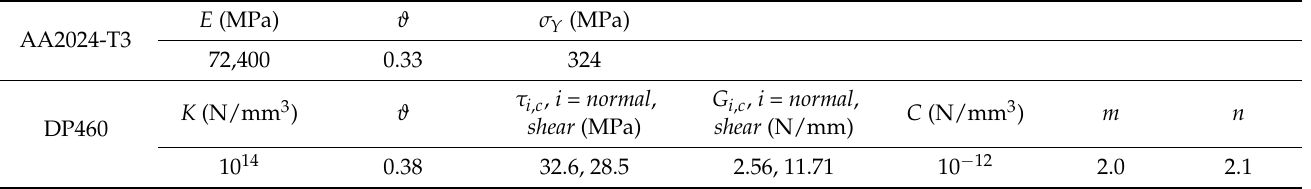
Table 1. The material parameters for AA2024-T3 and DP460 used in the FE simulations [21,30]. E (MPa) ϑ σ Y AA2024-T3